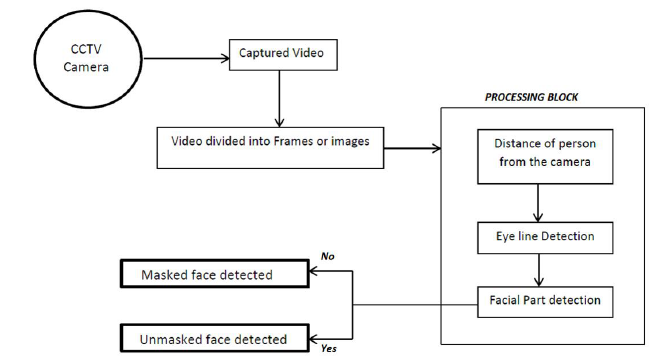
Fig. 1. System that detects mask on a person’s face using Viola Jones